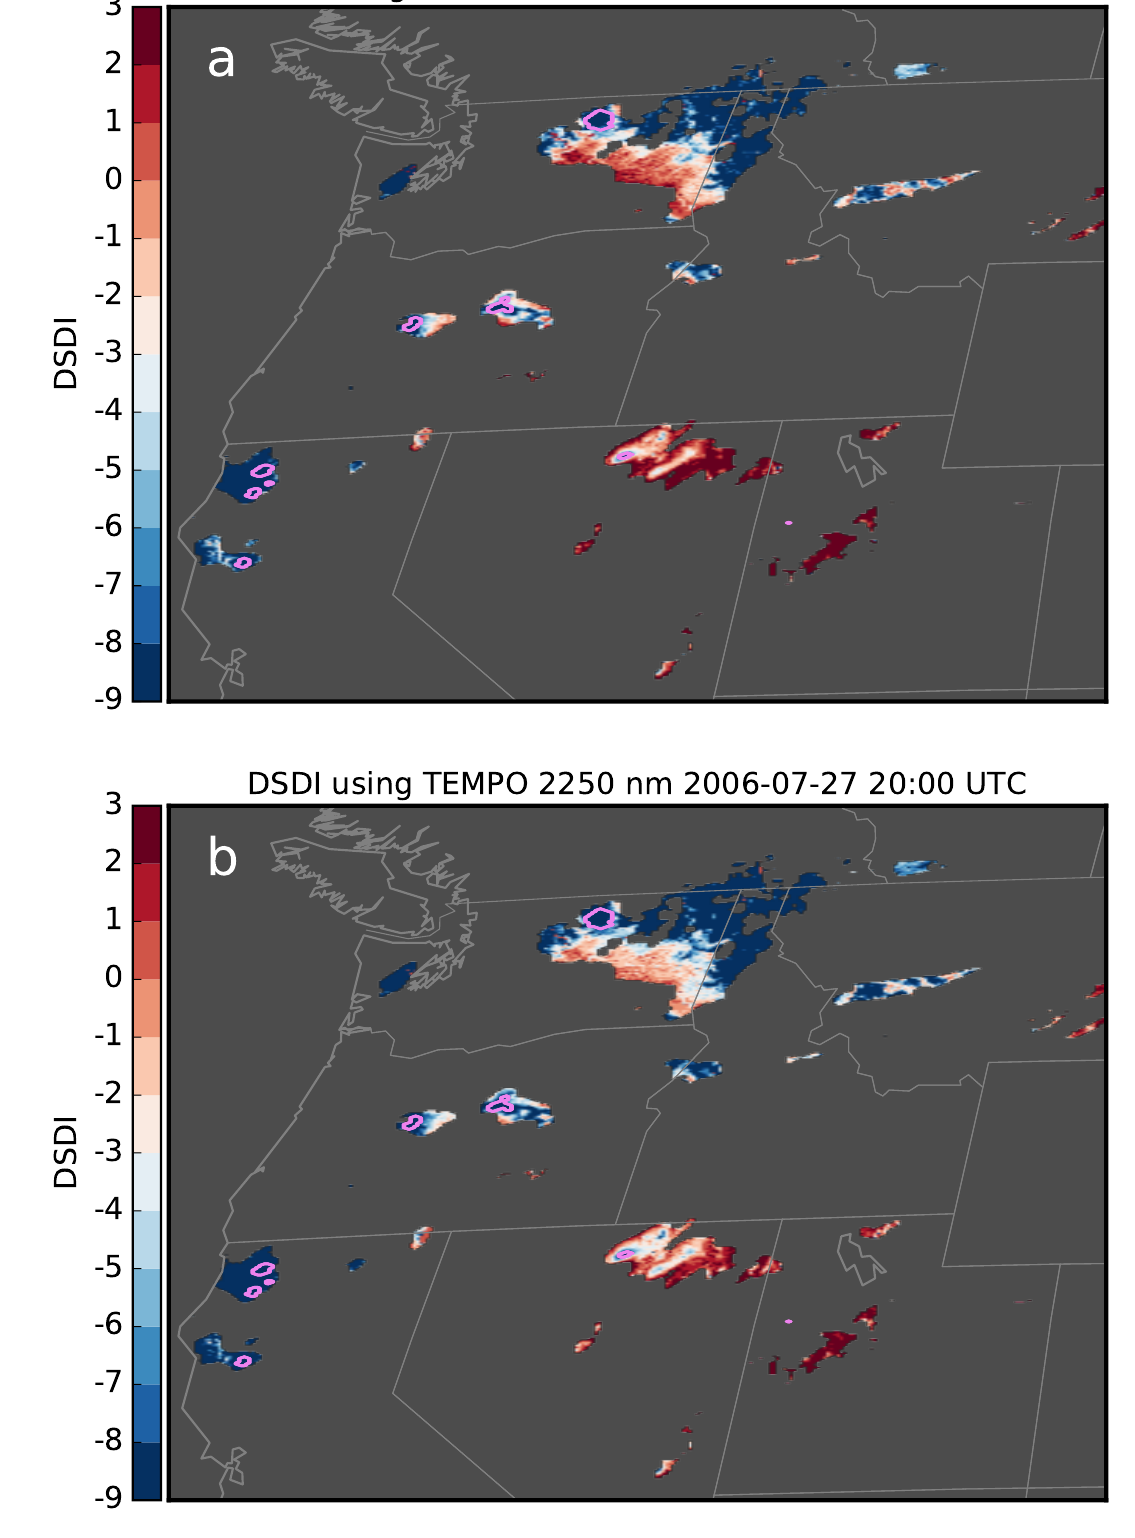
Figure 14. ( a ) Simulated Dust-Smoke Discrimination Index (DSDI) using combined TEMPO 412 nm reflectance and GOES-R 2250 nm reflectance, ( b ) DSDI using only TEMPO 412 nm and 2250 nm reflectance for 27 July 2006 at 21 UTC in the G5NR simulation. The purple contours represent the areas that were detected as smoke by the VIIRS aerosol detection